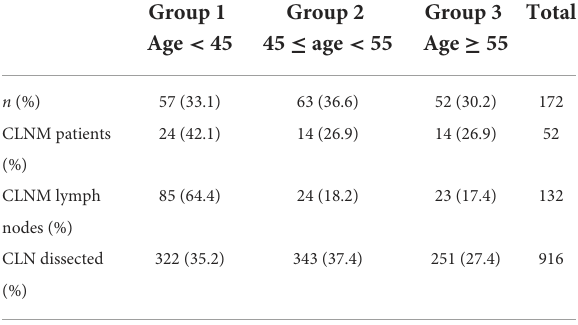
TABLE 1 Clinical characteristics and results of US imaging and pathologic assessments of the patients.